Question: In one sentence, what is this figure communicating?
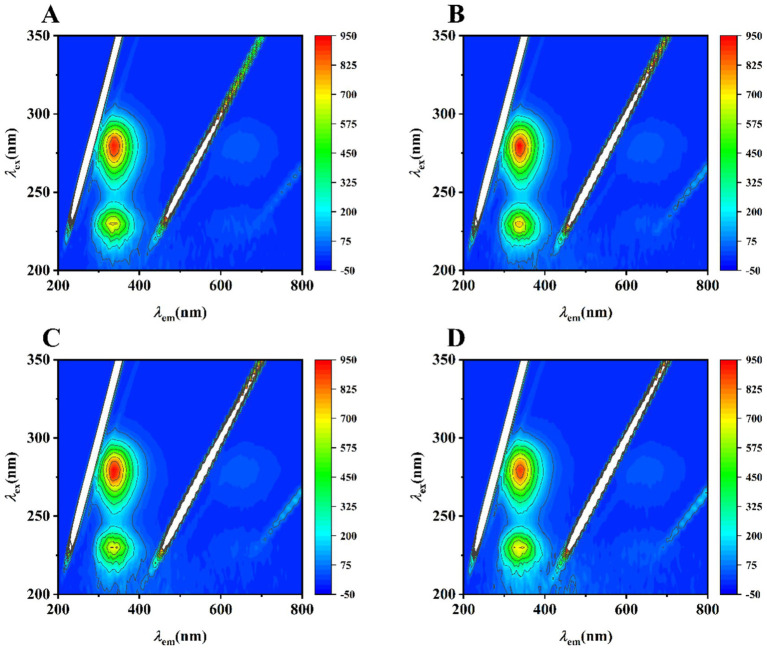
Answer: Three-dimensional fluorescence spectra of milk with different milk fat contents in 0% (A) , 2% (B) , 4% (C) and 6% (D) groups ( n = 3).